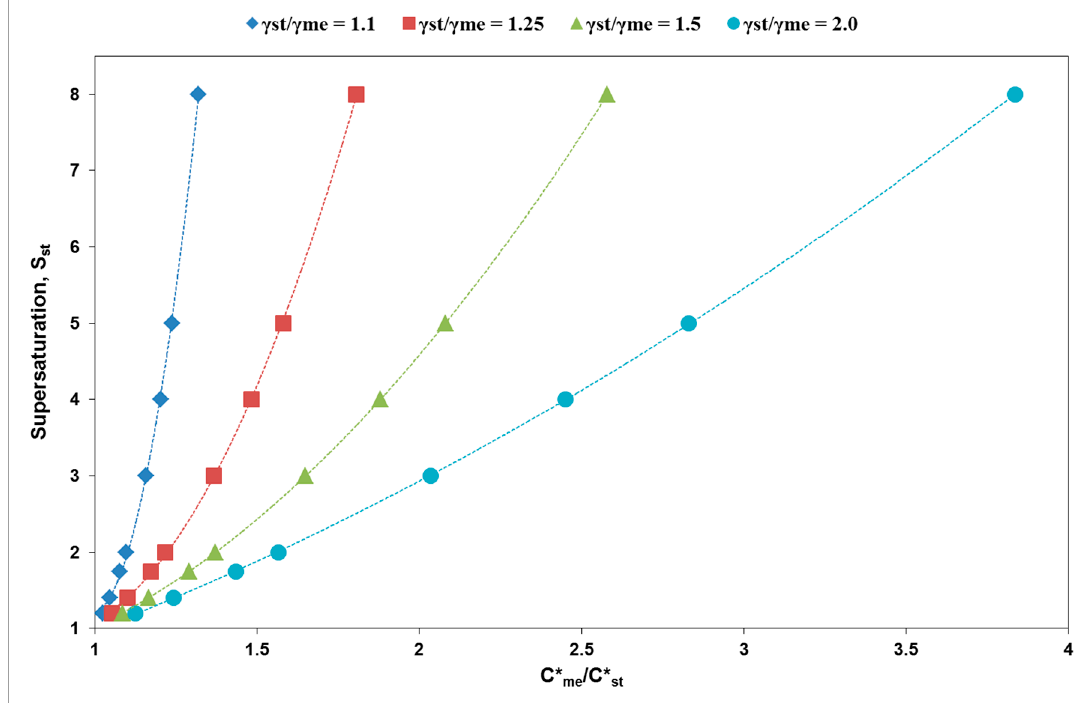
Figure 3. Domain diagram. For each characteristic ratios of equilibrium solubilities ( C * me / C * st ) and interfacial energies ( γ st / γ me ), the plot presents the supersaturation with respect to the stable polymorph ( S st ) at which the ∆ G * c values are equal. If the value for an equilibrium solubility ratio fall below its interfacial energy ratio line then ∆ G * c,st < ∆ G * c,me and the stable polymorph is predicted. Conversely, where this point falls above any interfacial energy ratio line then ∆ G * c,me < ∆ G * c,st and the metastable polymorph is predicted.